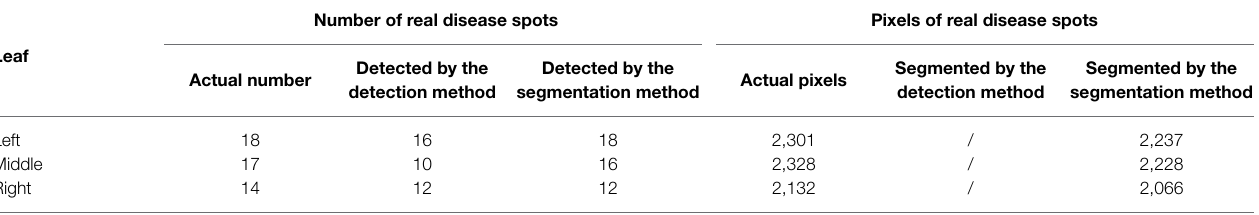
TABLE 5 | Detection statistics results of the two methods for the grape leaves in Figure 11 .